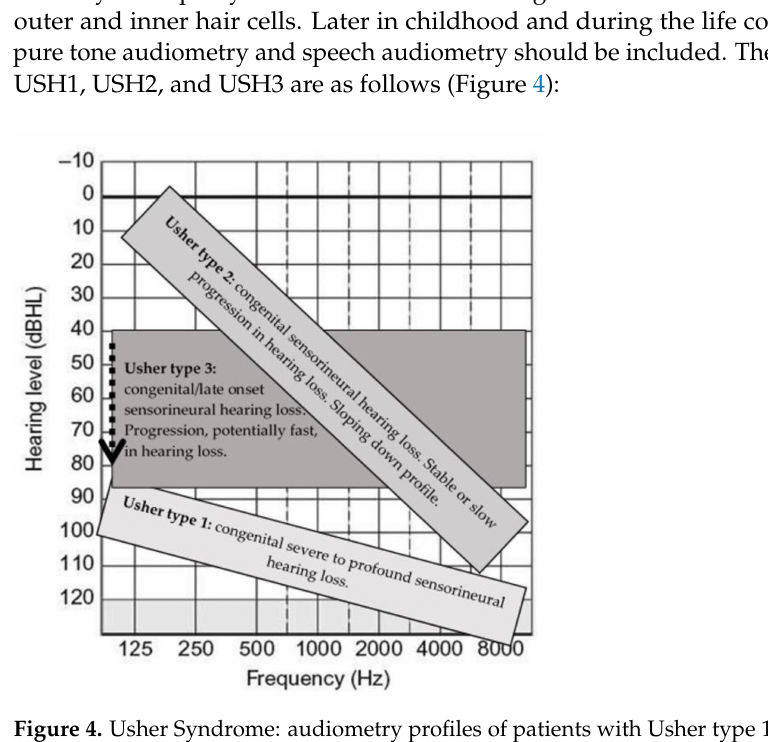
Figure 4. Usher Syndrome: audiometry profiles of patients with Usher type 1, 2, and 3. Hearing loss is bilateral, symmetric, and sensorineural for all